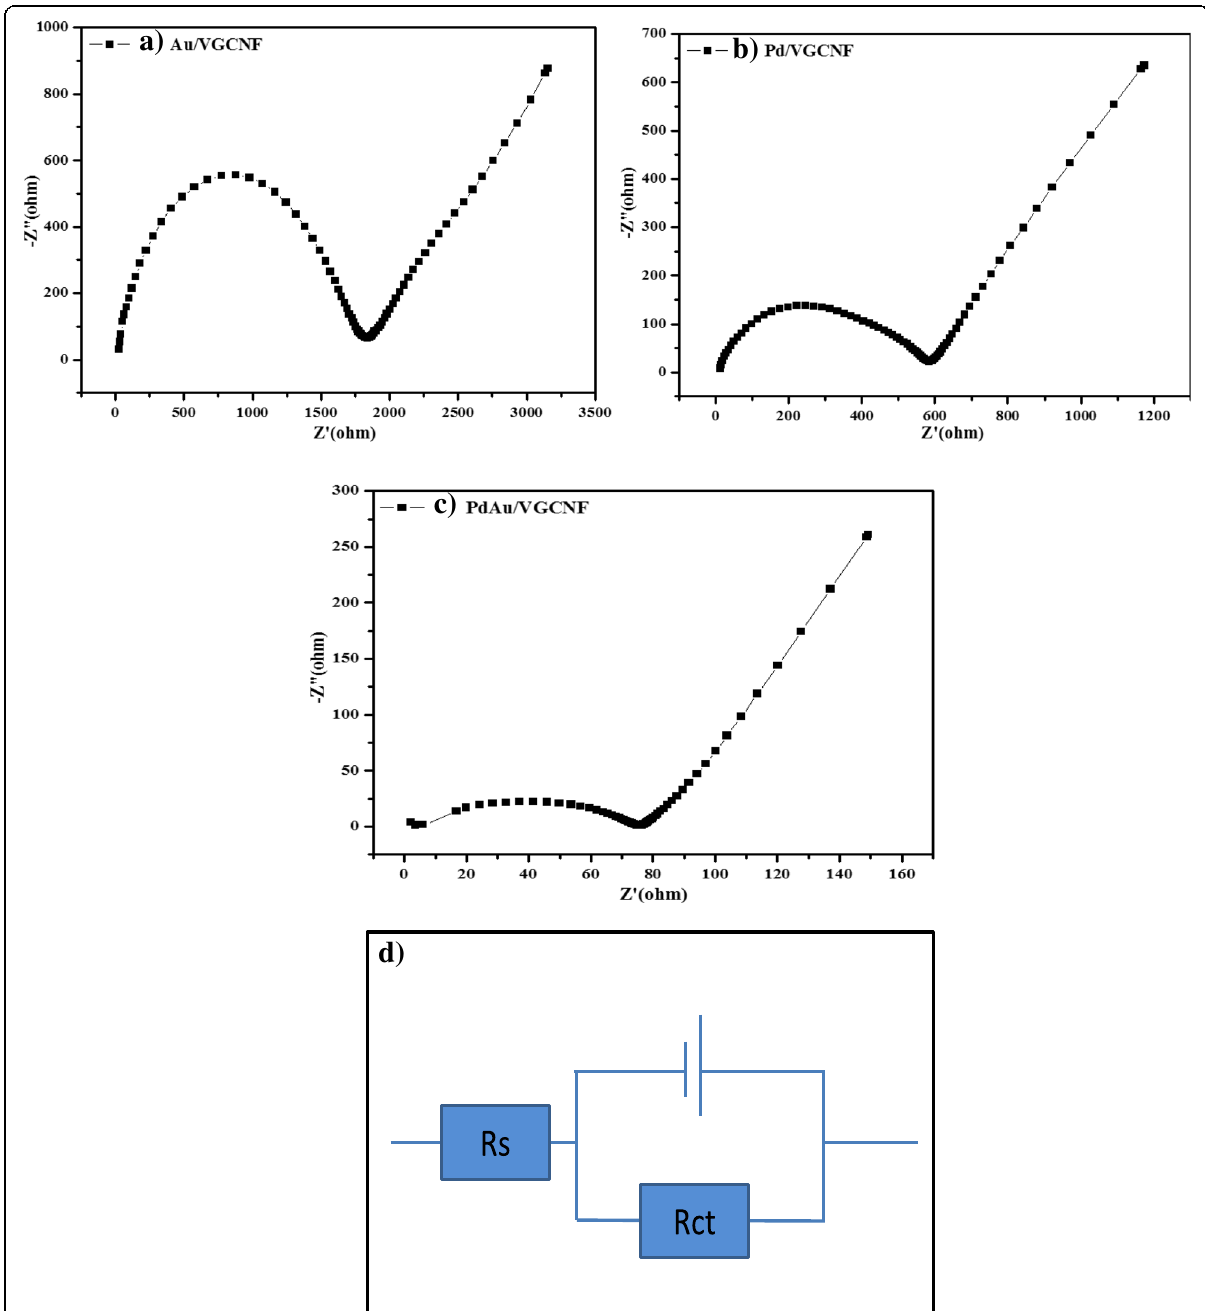
Fig. 9 Nyquist plots of electrochemistry impedance spectra for glycerol oxidation reaction of a Au/VGCNF, b Pd/VGCNF, c PdAu/VGCNF, and d